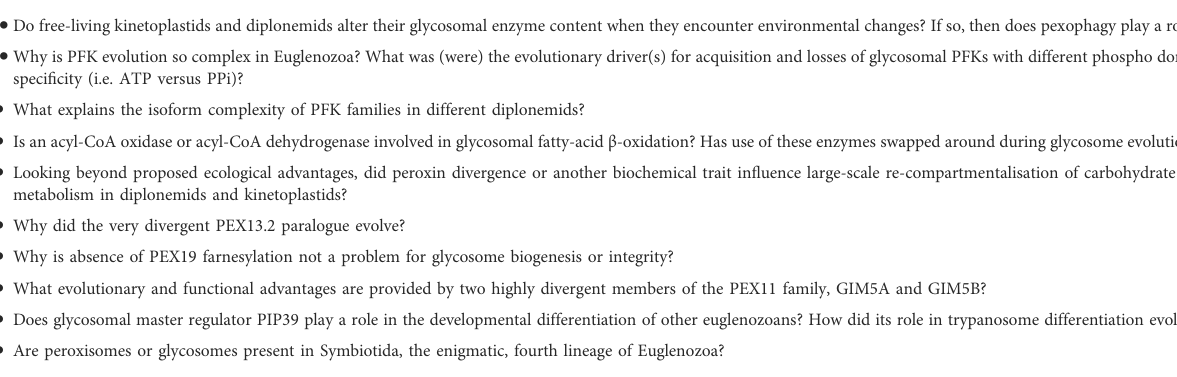
TABLE 1 Outstanding questions about glycosome evolution. (cid:129) Do free-living kinetoplastids and diplonemids alter their glycosomal enzyme content when they encounter environmental changes? If so, then does pexophagy play a